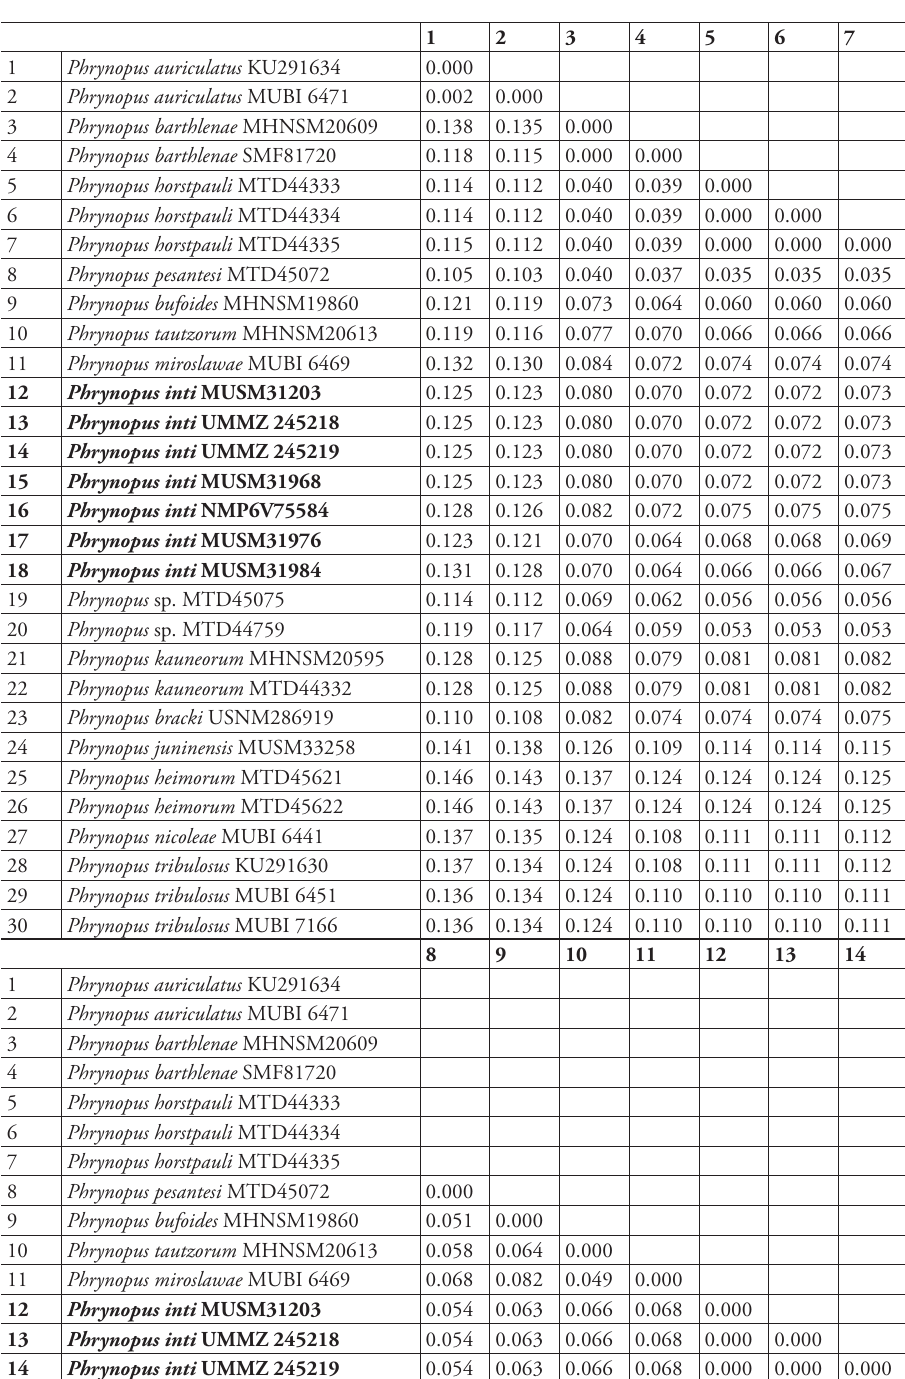
Table 2. Uncorrected p-distances of the 16S mitochondrial rRNA gene for 30 specimens of Phrynopus , including the new